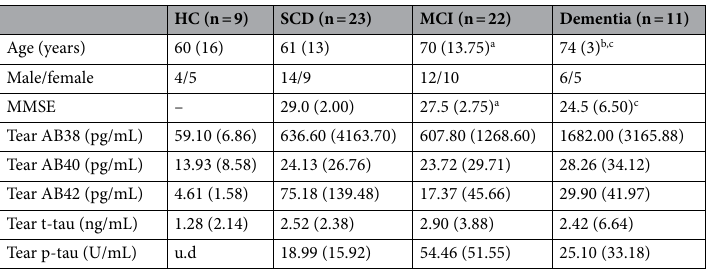
Tear fluid biomarker detectability n